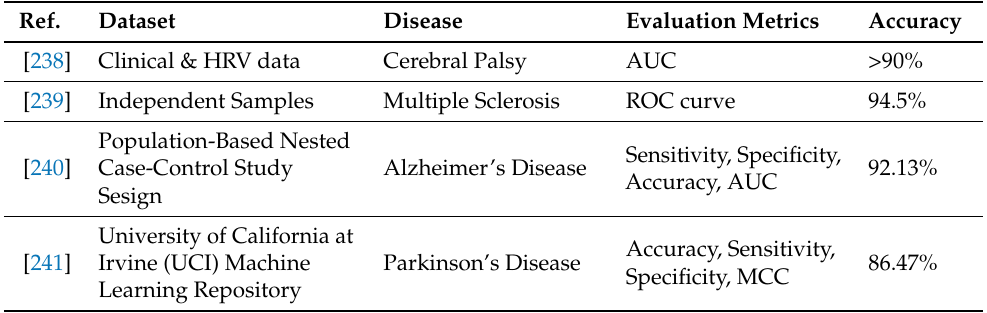
Table 13. ANN classifier result analysis on various NDs. Ref.